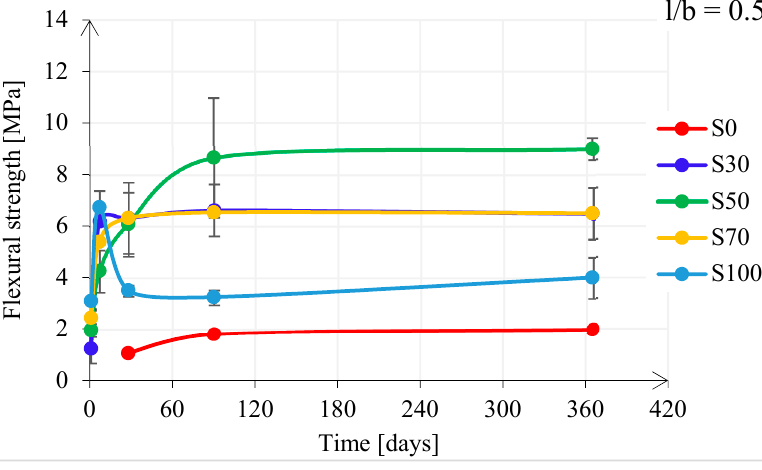
Figure 15. Flexural strength development for pastes with l/b = 0.5.